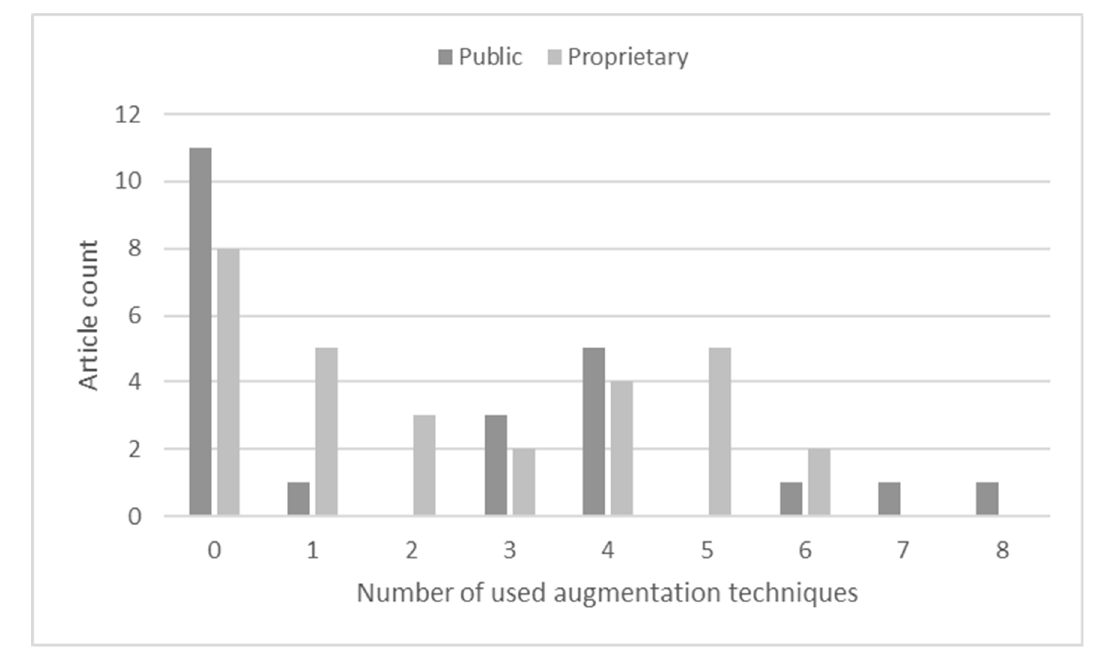
Figure 6. Number of augmentation techniques used.